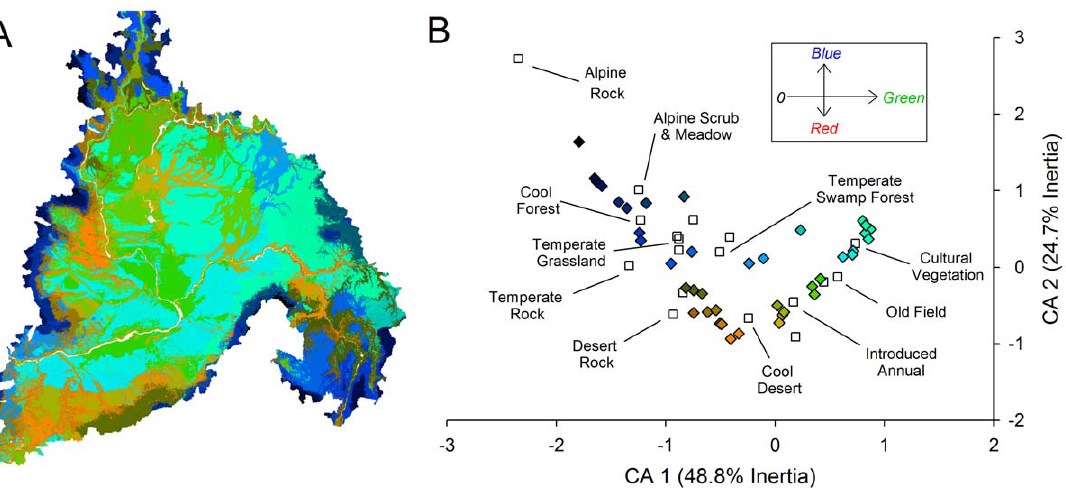
Figure 3. Abiotic facet distribution and correspondence with vegetation. This map depicts abiotic facets for the Columbia Plateau ecoregion (A). The ordination joint plot displays the correspondence between these abiotic facets (filled diamonds) and vegetation cover (open squares) (B). Select vegetation types are labeled in the ordination and abiotic facets are color-coded relative to their position on the ordination axes. Abiotic facets and vegetation types that occur in close proximity in the joint plot co-occur more frequently in the ecoregion.